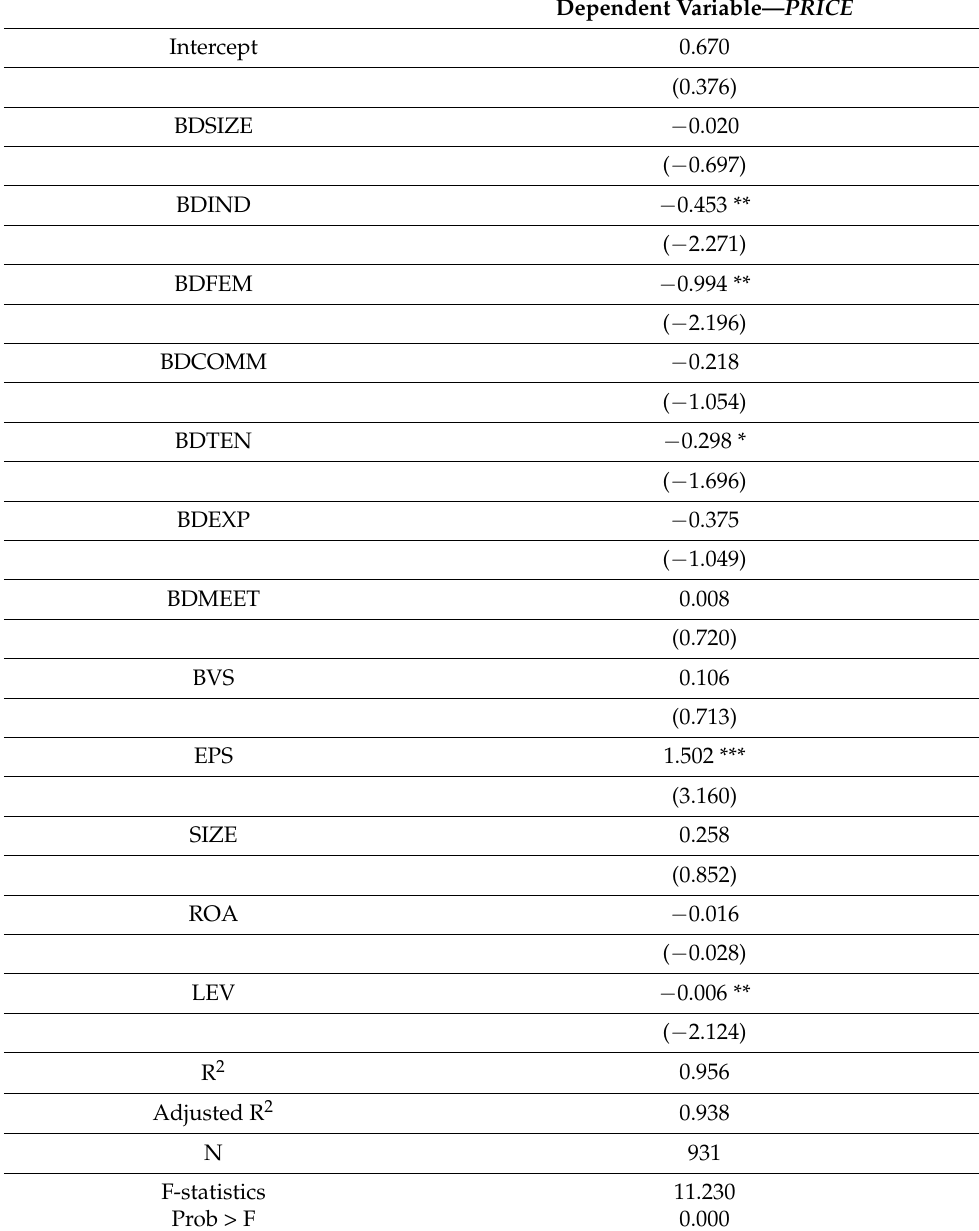
Table 6. Results of regression of board attributes on PRICE